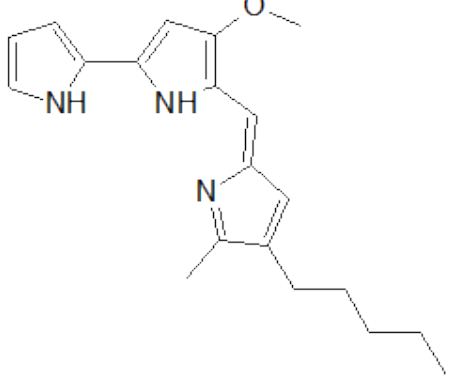
Figure 9. Prodigiosin is a secondary metabolite of the bacterium Serratia marcescens. The anionophore prodigiosin transports chloride and bicarbonate ions through biological membranes of living cells.